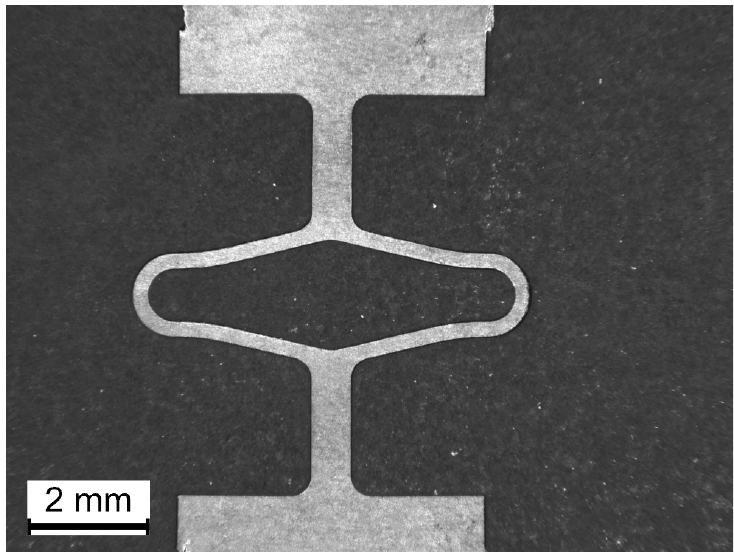
Figure 6. Representative image of a diamond-like element, laser-cut from the straight-annealed NiTi sheets.